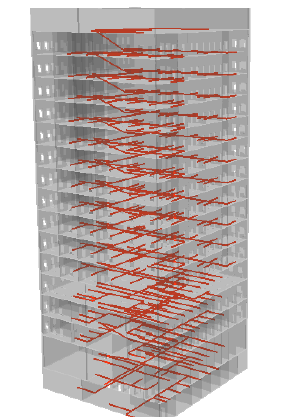
Figure 9. Plasco building path network and